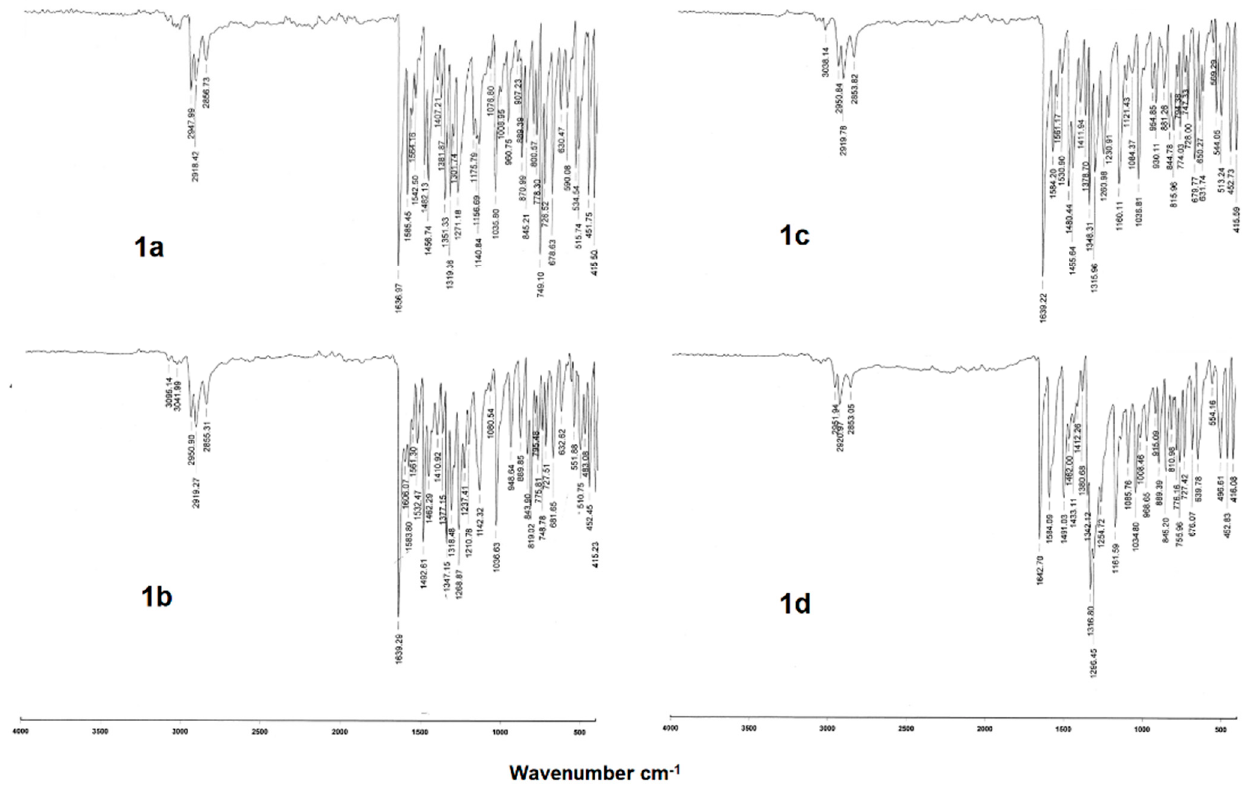
Figure 2. IR spectra of heptacoordinated organotin (IV) complexes (KBr).